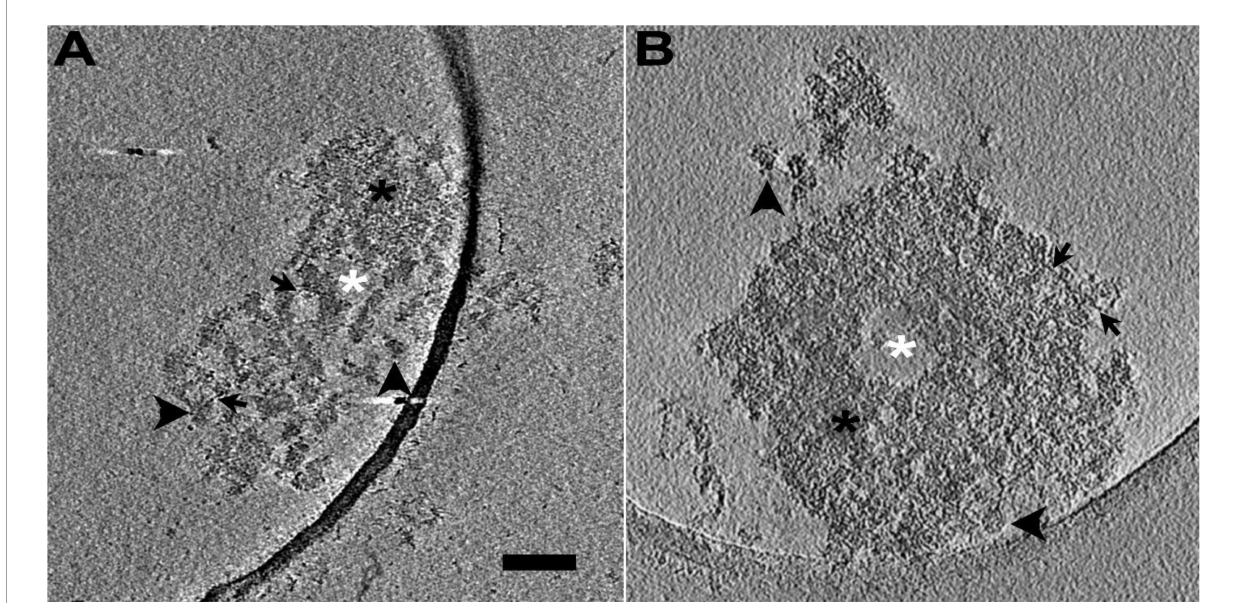
FIGURE1 Isolated PSDs with and without sonication, imaged by cryo-EM tomography. (A) A 1.4-nm-thick virtual slice through a reconstructed volume of a sonicated PSD. The slice shows electron-dense structures apparently completely isolated from other structures (vertical black arrowhead), those apparently incompletely disconnected from other structures showing a few connections with adjacent ones though they were noticeably away from each other in most of their parts (horizontal black arrowhead), other apparently condense structures (black asterisk), and empty spaces devoid of such structures (white asterisk) including filamentous structures (black arrow). (B) A 1.3-nm-thick virtual slice through a reconstructed volume of an isolated PSD without sonication (control PSD). The slice also shows electron-dense structures apparently completely isolated from other structures (horizontal black arrowhead), those incompletely isolated from other structures (vertical black arrowhead), other apparently condense structures (black asterisk), and empty spaces devoid of such structures (white asterisk) including filamentous structures (black arrow). Scale bar = 100 nm.